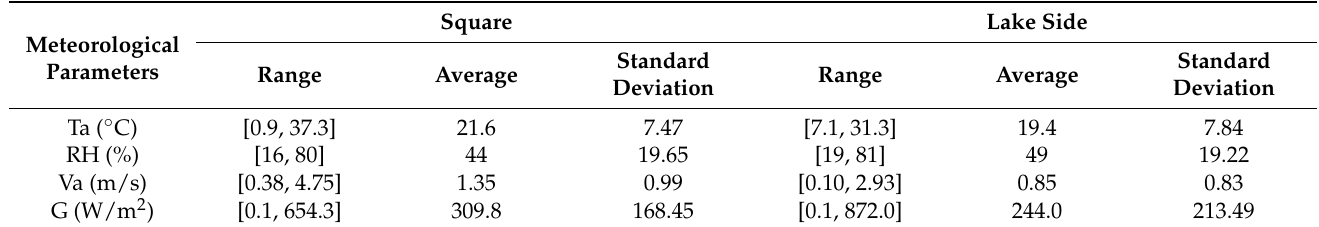
Table 4. Data of meteorological